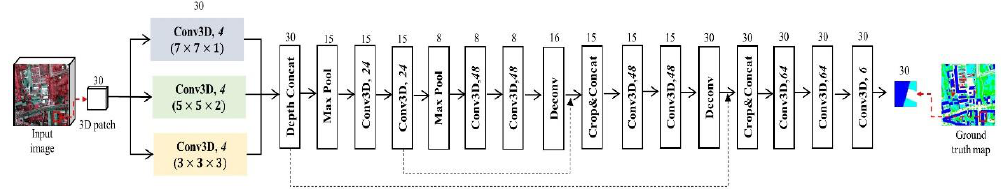
Figure 1. Illustration of a fully convolutional network containing multiple three-dimensional (3D) filters for semantic segmentation. “Conv3D”, “Max pool”, and “Deconv” represent the 3D convolutional layer, max pooling layer, and deconvolutional layer, respectively. The numbers on the boxes represent the pixel size of the input images and italic fonts mean the output number of layers. For example, “30” means the output size of the layers is 30 × 30 pixels and “6” represents the number of final feature maps is